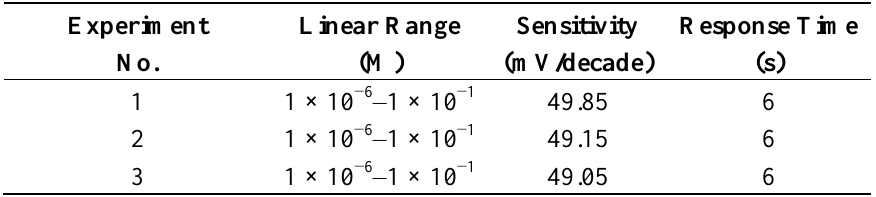
Table 1. The repeatability response for a single electrode in three different independent